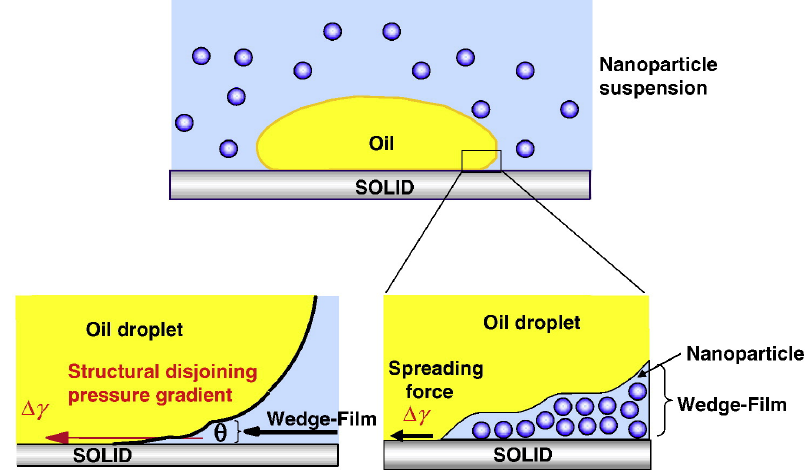
Figure 13. Scheme of the disjoining pressure acting on an oil droplet. Figure reproduced from Refs.